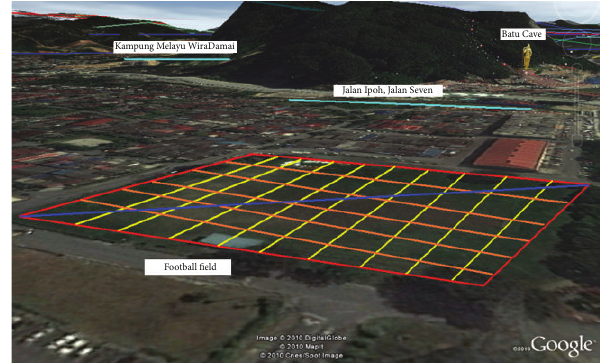
Figure 3: Map from Google Earth showing alignment of resistivity lines on the study area and two additional lines: one near the river and the other near Batu Cave